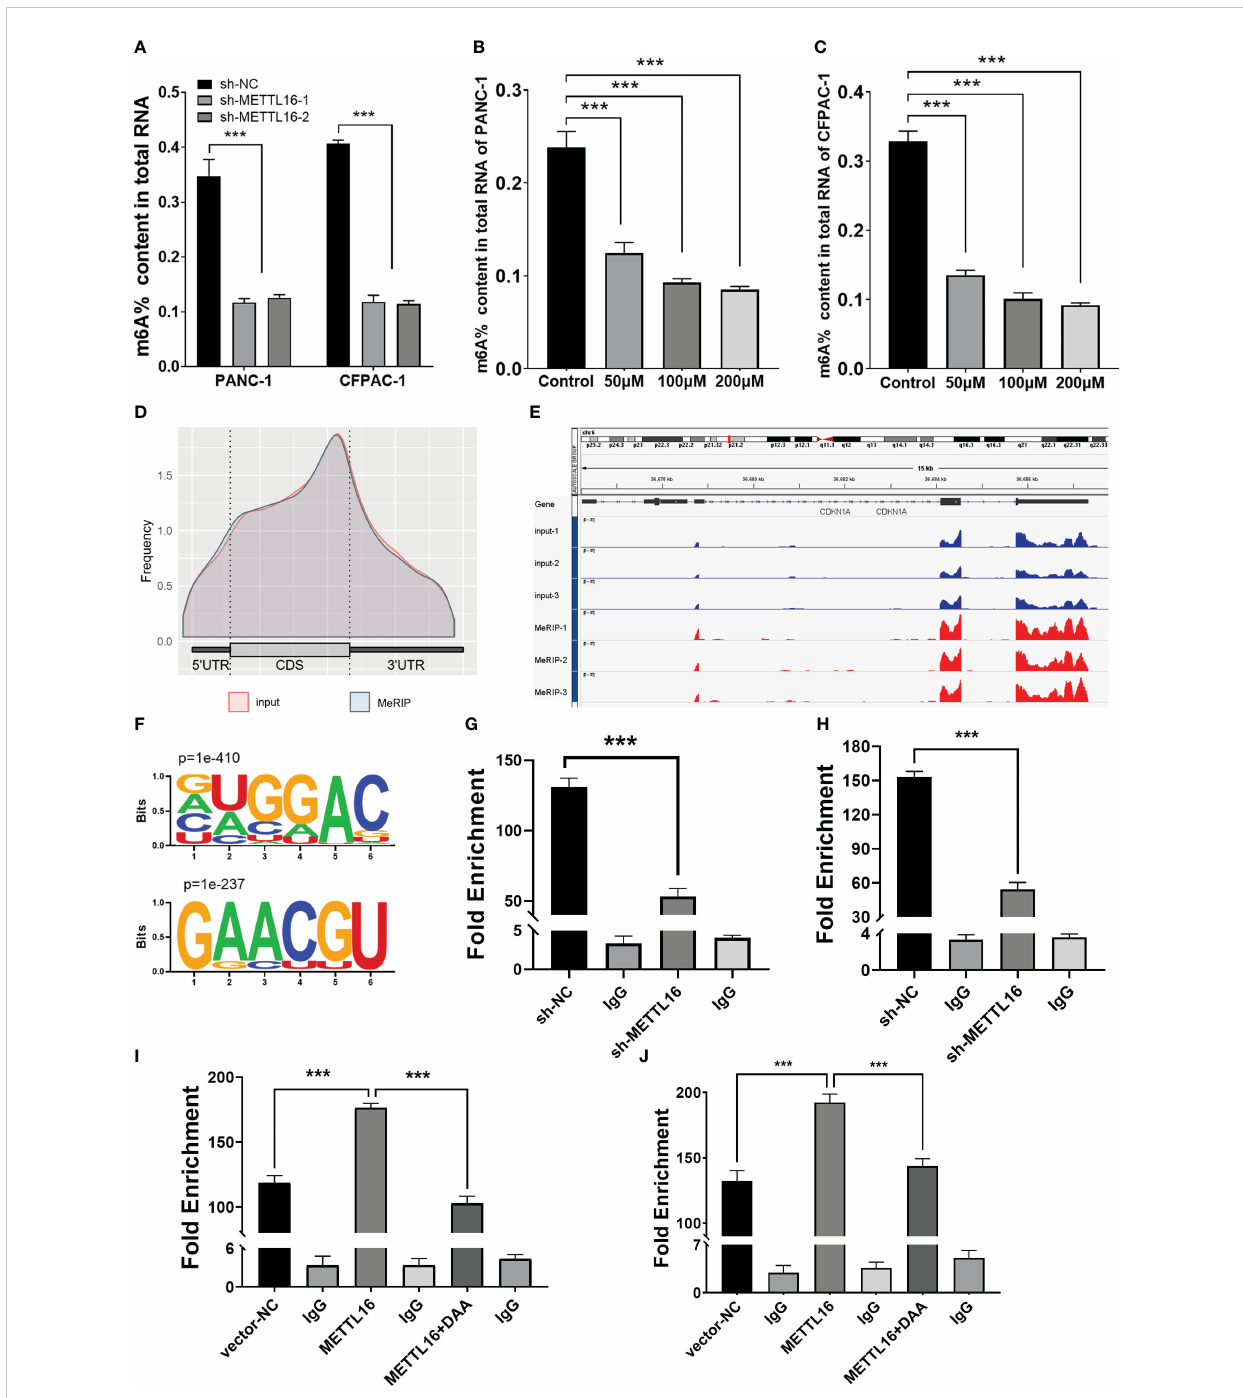
FIGURE 5 MeRIP-seq analysis revealed that METTL16 activates CDKN1A via m6A-related mechanisms. (A) Quantitative RNA methylation analysis based on a standard curve was used to detect the overall content of m6A in sh-NC and sh-METTL16 PANC-1 and CFPAC-1 cells. The global level of m6A methylation in PANC-1 (B) and CFPAC-1 (C) cells treated with different concentrations of DAA (0 µmol/L, 100 µmol/L, 200 µmol/L) for 24 h are shown. (D) Metagene plot of the m6A peak distribution in mRNA. (E) IGV analysis showed the binding peaks of the target gene (CDKN1A) in the genome. (F) Global pro fi ling of m6A in PANC-1 cells with the most interesting sequence motifs of m6A peaks indicated. MeRIP-qPCR assays with an anti-m6A antibody or IgG were performed to verify the enrichment of CDKN1A mediated by METTL16 at m6A-related peaks of interest. The m6A modi fi cation of CDKN1A was increased upon overexpression of METTL16 (I, J) , while it was depleted upon knockdown of METTL16 (G, H) or addition of DAA (I, J) in both PANC-1 and CFPAC-1 cells. *** means